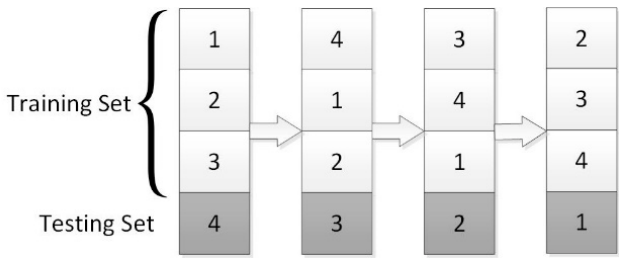
Figure 2. Illustration of Cross Validation.